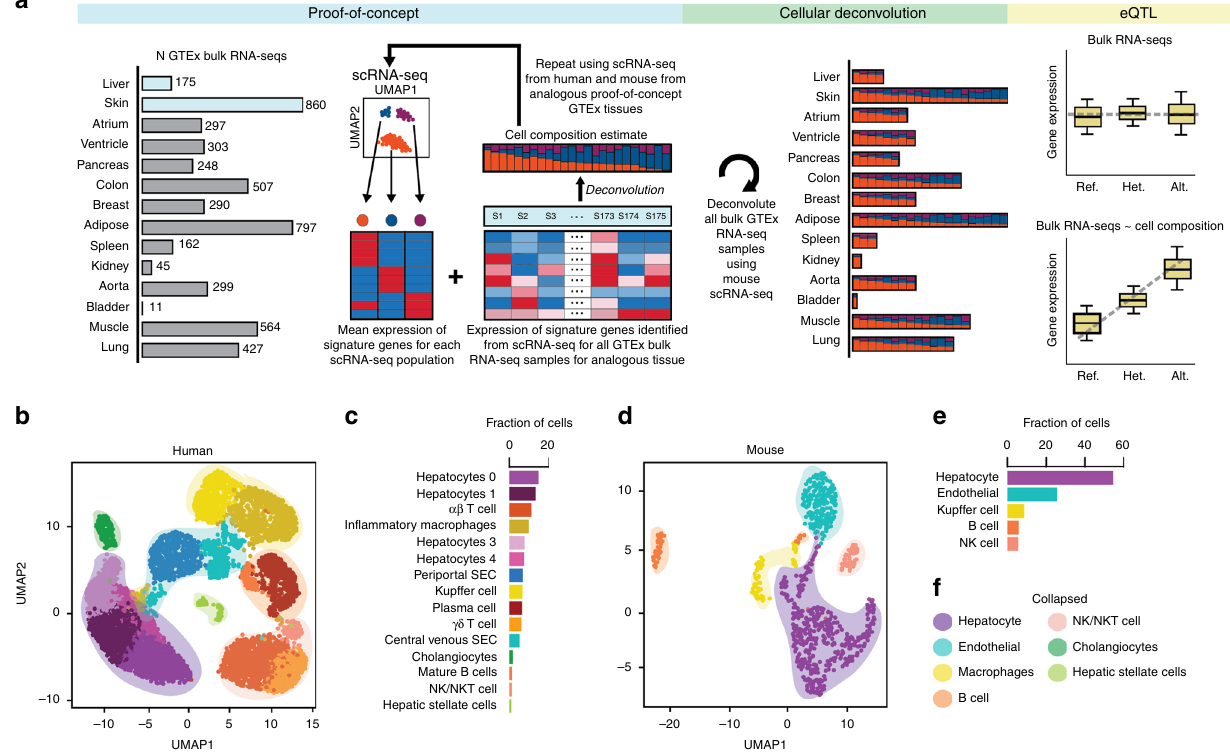
Fig. 1 Human and mouse liver scRNA-seq contains similar cell types. a Overview of the study design, which was to deconvolute the cellular composition of 28 GTEx tissues from 14 organs using mouse scRNA-seq to identify cell-type-associated eQTLs. We fi rst conducted proof-of-concept analyses, where we compared cellular estimates of two proof-of-concept GTEx tissues (liver and skin) deconvoluted using both mouse and human signature genes obtained from scRNA-seq. We then performed cellular deconvolution of the 28 GTEx tissues from 14 organs using CIBERSORT and characterized both the heterogeneity in cellular composition between tissues and the heterogeneity in relative distributions of cell populations between RNA-seq samples from a given tissue. Finally, we used the cell type composition estimates as interaction terms for eQTL analyses to determine if we could detect cell-type- associated genetic associations. b UMAP plot of clustered scRNA-seq data from human liver. Each point represents a single cell and color coding of cell type populations are shown adjacent c . Similar cell types can be collapsed to single cell type classi fi cations and are noted with colored, transparent shading f . c Bar plots showing the fraction of each cell type from human liver scRNA-seq data. Color-coding of cell types correspond to the colors of the single cells in b . d UMAP plot of clustered scRNA-seq data from mouse liver. Each point represents a single cell and color coding of cell type populations are shown adjacent e . Each cell type has a corresponding collapsed cell type in human liver and is noted with colored, transparent shading f . e Bar plots showing the fraction of each cell type from mouse liver scRNA-seq data. Color-coding of cell types correspond to the colors of the single cells in d . f showing the colors of collapsed similar cell types from human liver (transparent shading in UMAP b , d ; Supplementary Table 2). All cell types from mouse liver have a corresponding collapsed cell type in human liver (hepatocyte, endothelial, macrophages, B cell, NK/NKT cell) and human liver also contains two additional cell types not present in mouse (cholangiocytes and hepatic stellate